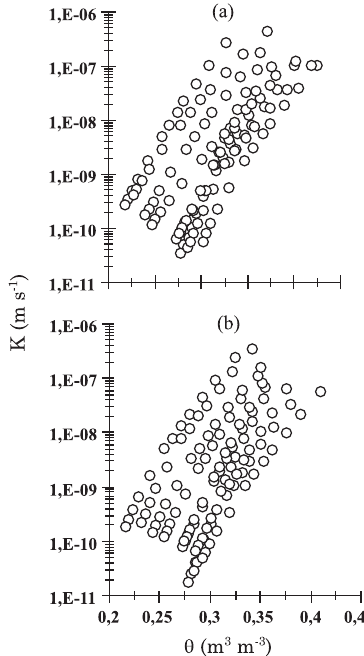
Figura 3. Variação da condutividade hidráulica (K) com a umidade volumétrica ( θθθθθ ) correspondente a todas as camadas do perfil de solo: (a) bateria de tensiômetros da esquerda e (b) bateria de tensiômetros da